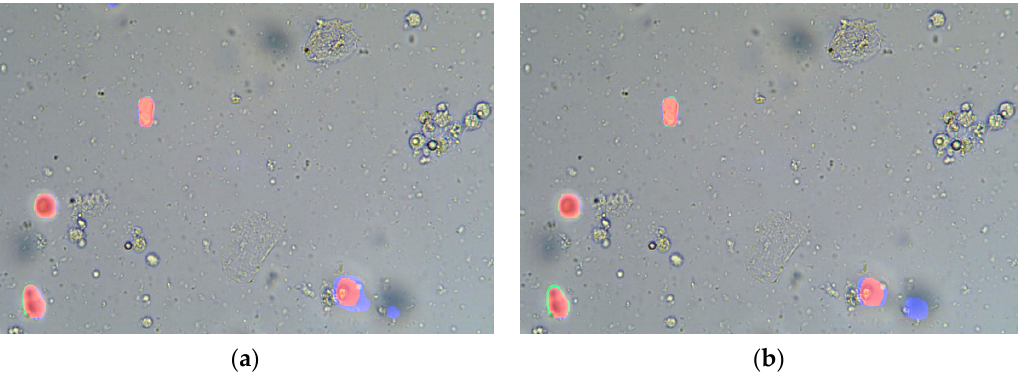
Figure 10. Limitations of the fine detection network. For convenience of display, we have used red to mark the TP regions, green to mark FN regions and blue to mark FP regions of TV on the original image. ( a ) The rough detection result; ( b ) the fine detection result.